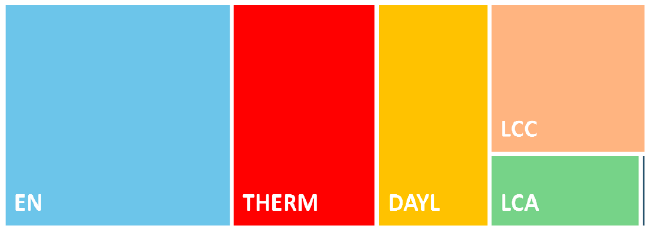
Figure 5. Objective functions evaluated in the reviewed journal articles. A larger area corresponds to a higher number of works that optimized that function.